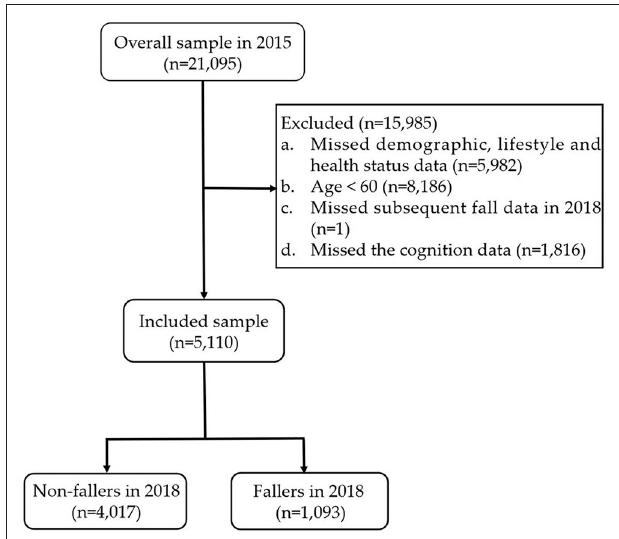
FIGURE 1 | Participants included in the